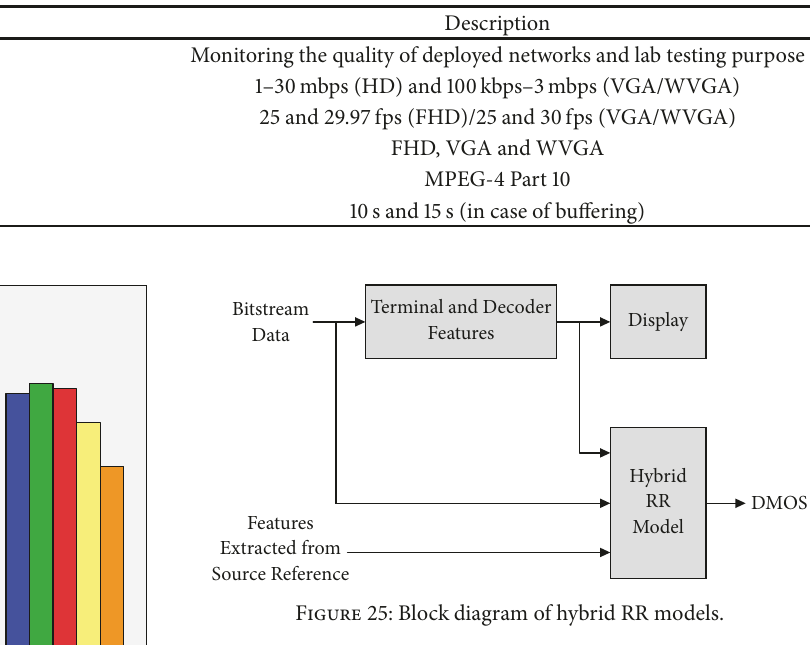
Figure 25: Block diagram of hybrid RR models.